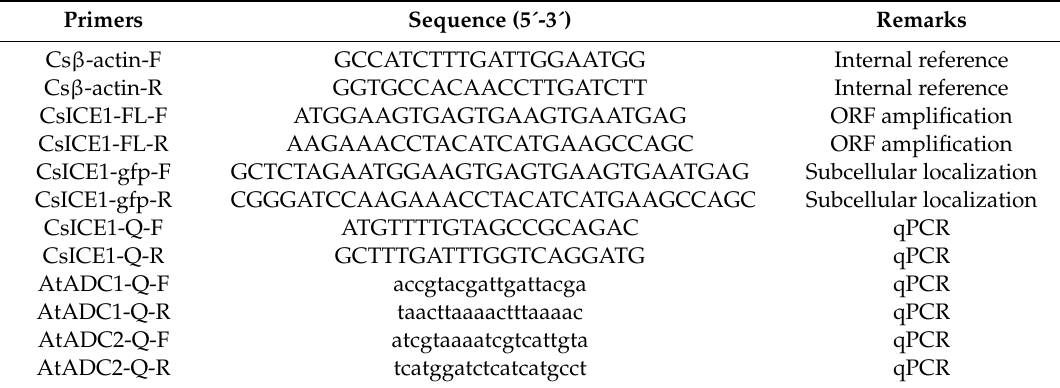
Table 1. Primers used in the study of gene expression